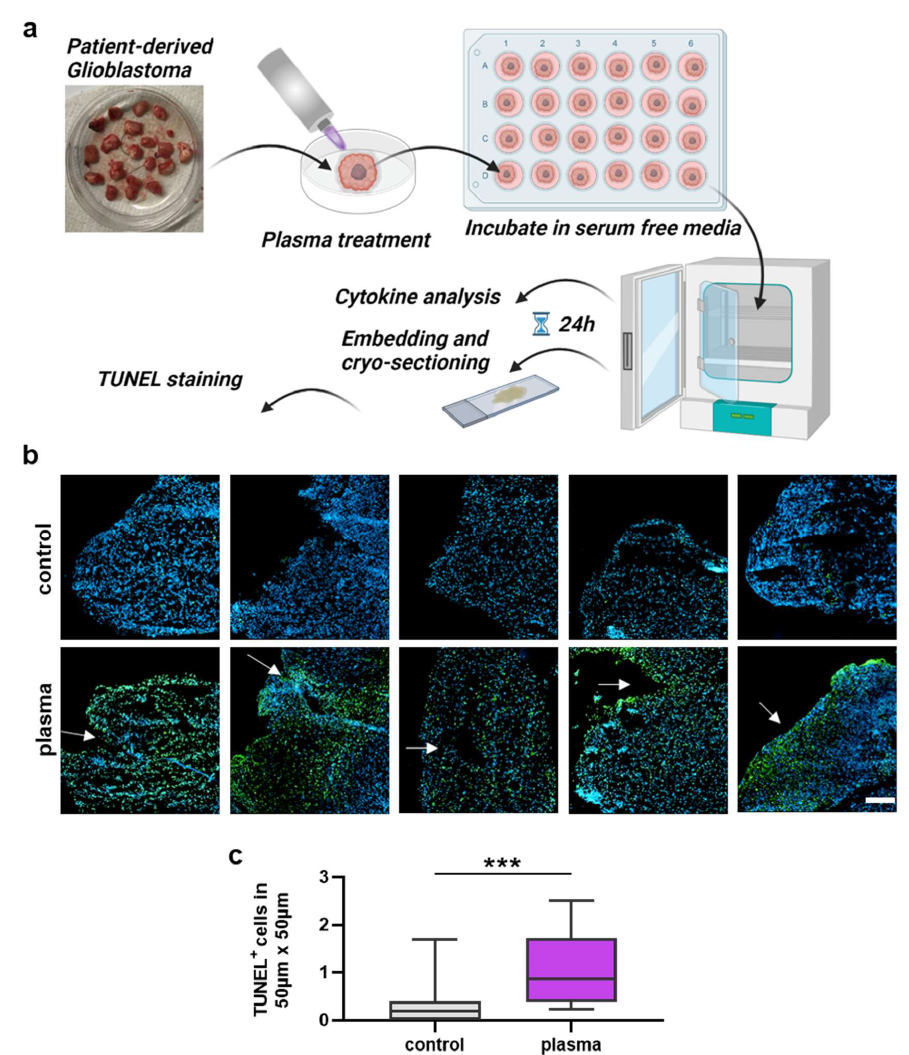
Figure 3. Patient-derived GBM tumor sample analysis. ( a ) Study protocol; ( b ) examples of highly apoptotic (TUNEL + , green) patient-derived glioblastoma multiforme tissue ultrathin cryosections following gas plasma exposure (nuclei counterstained with DAPI in blue); ( c ) algorithm-driven quantitative image analysis of tissue sections for TUNEL + (apoptotic) cells per area. Data are box plots (Tukey) from 16 patient samples; statistical analysis was performed using two-tailed Mann– Whitney test with p < 0.001 (***) differing significantly. Scale bar is 150 µm.